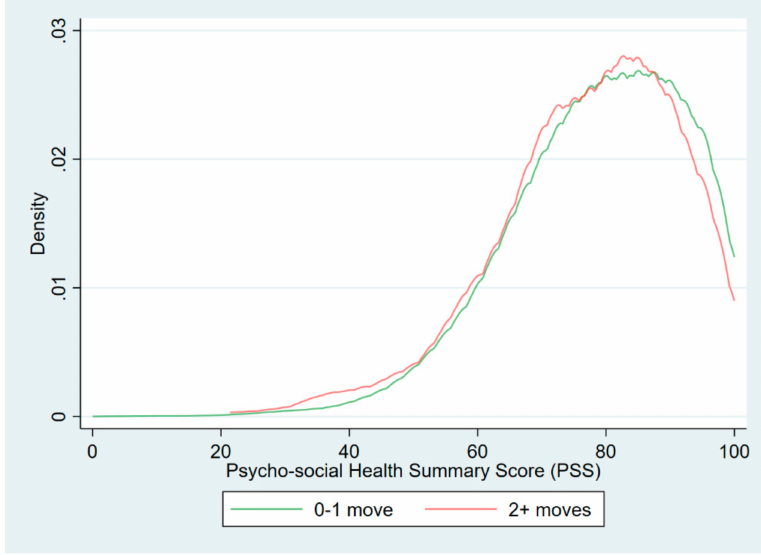
Figure A2. Distribution of Psycho-social Health Summary